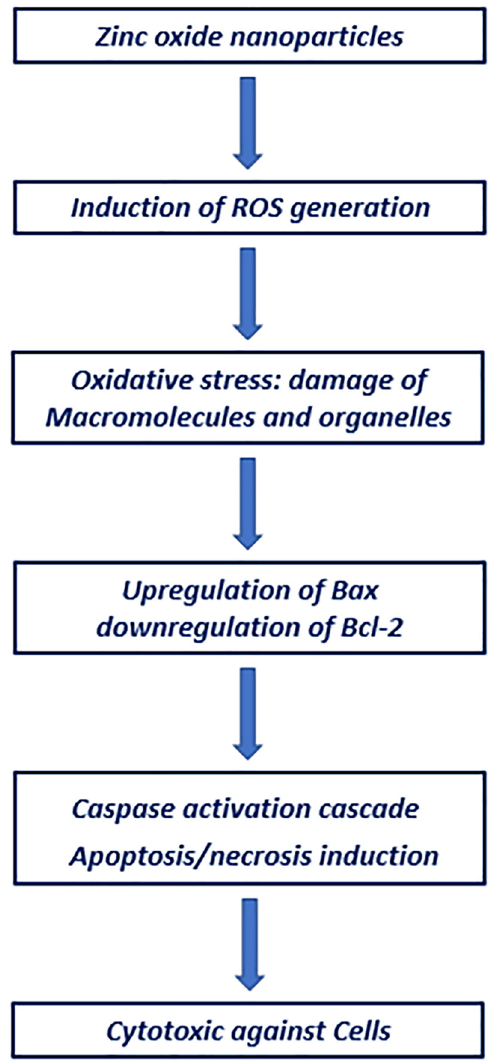
Figure 6: Mechanism of toxicity of ZnO - NPs against cell